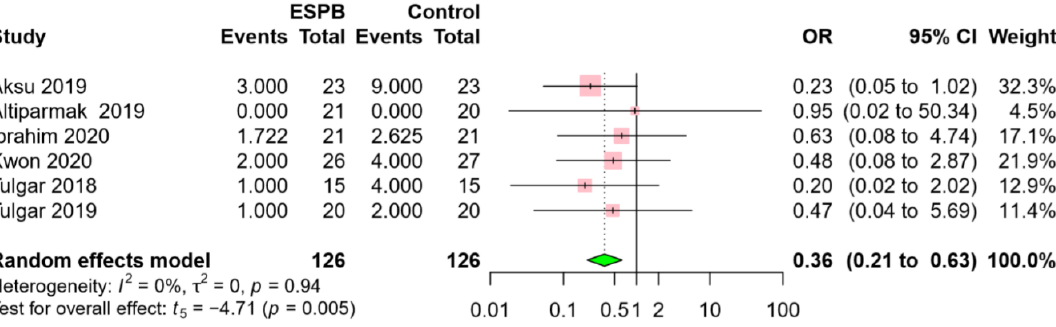
Figure 4. Forest plot for pain scores: ( a ) postoperative 12 h, ( b ) postoperative 24 h. ESPB provided lower pain scores until postoperative 12 h. Abbreviations: ESPB, erector spinae plane block; MD, mean difference; SD, standard deviation; CI, confidence interval.